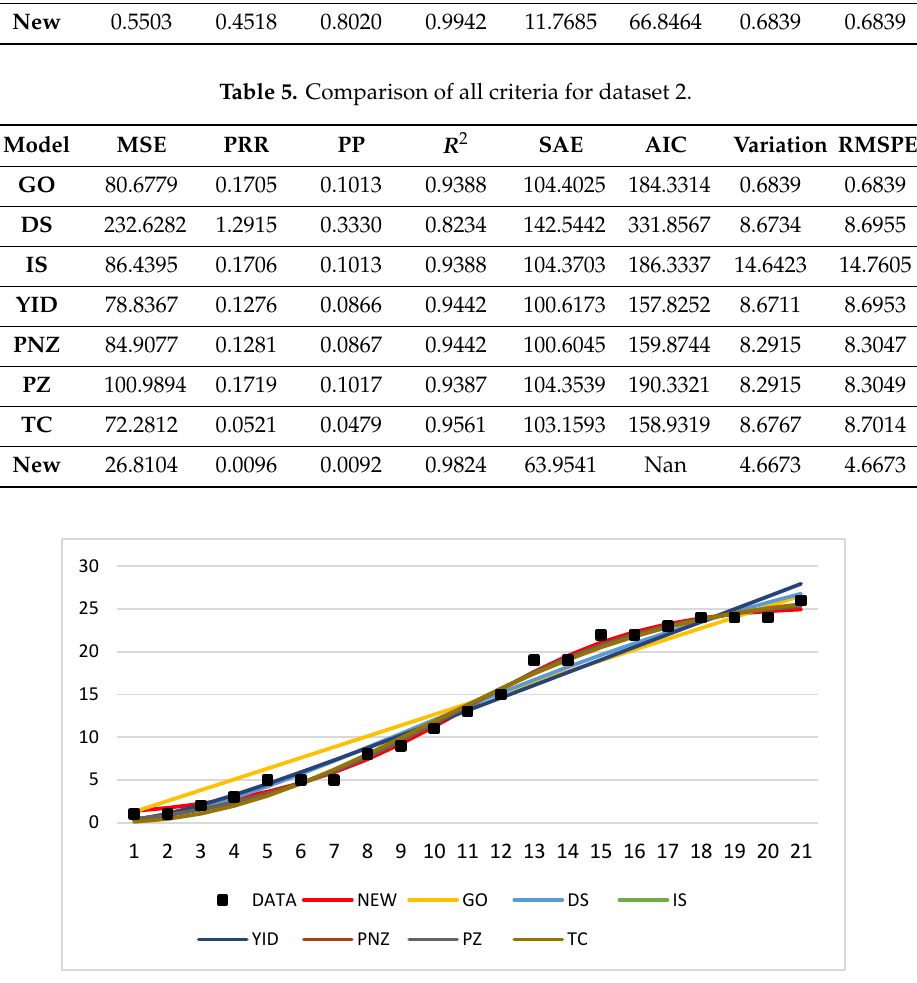
Figure 3. Mean value functions, m(t), of all models for dataset 1.